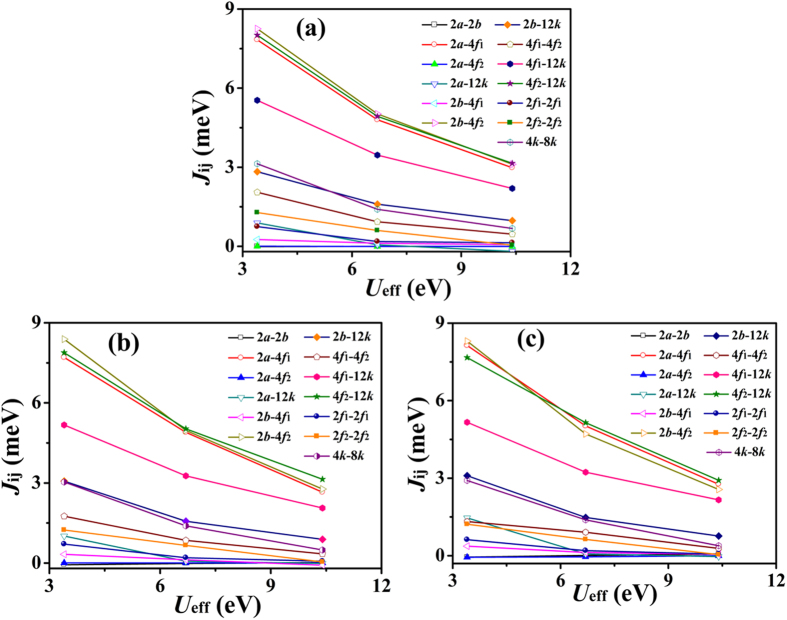
The exchange integrals as a function of Ueff for Ba1−xLaxFe12O19 samples.(a) x = 0.0, (b) x = 0.5, (c) x = 1.0.